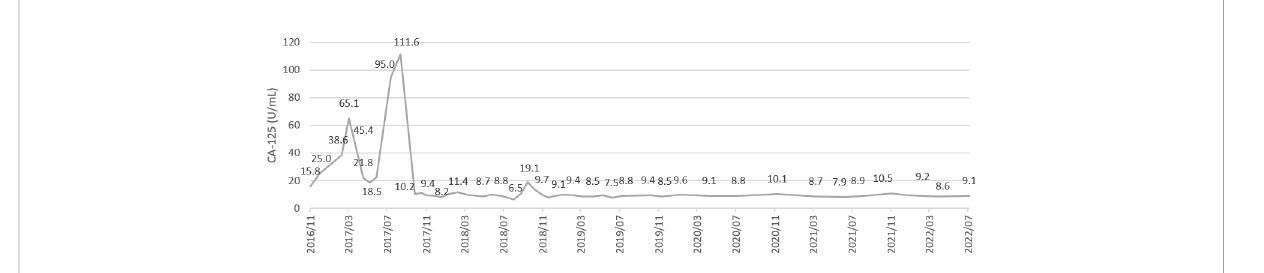
FIGURE 3 A serial values of tumor marker CA-125 during treatment and follow-up. CA-125 level 111.6 and 19.1 U/ml at 1 st and 2 nd recurrence